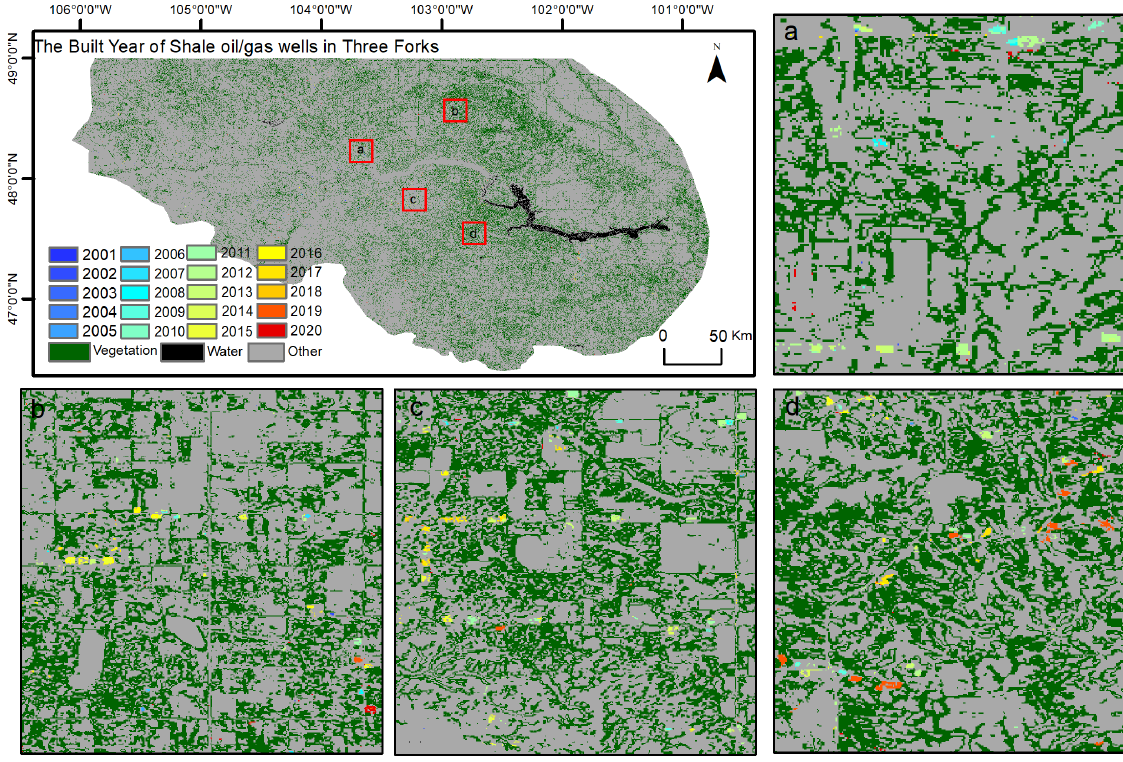
Figure 9. Disturbance map of shale gas wells built in Three Forks from 2000 to